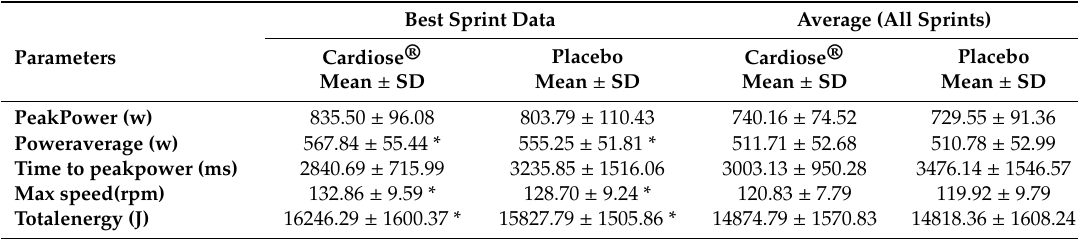
Table 2. Repeated sprint test outcomes.